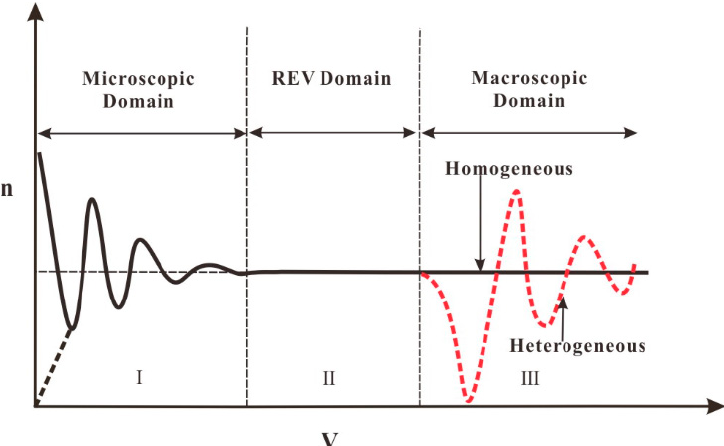
Figure 1. Schematic graph of the representative elementary volume (REV) (modified from [18,30]). Porosity generally varies with the sample’s volume in carbonate rocks. During meas ‐ urements, the testing data of traditional core plugs (a cylinder with a diameter of 2.5 cm and a height of 5 cm) have been commonly used to represent the data of whole